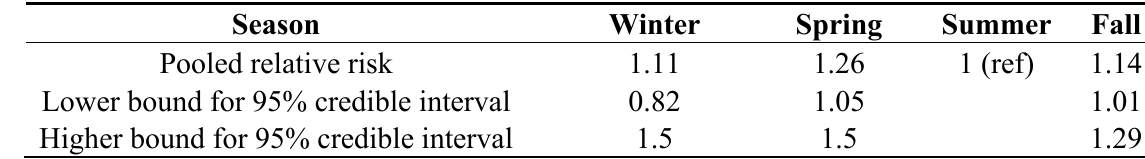
Table A7. Pooled relative risks and 95% credible interval for the association between season of birth on preeclampsia incidence after excluding [22].